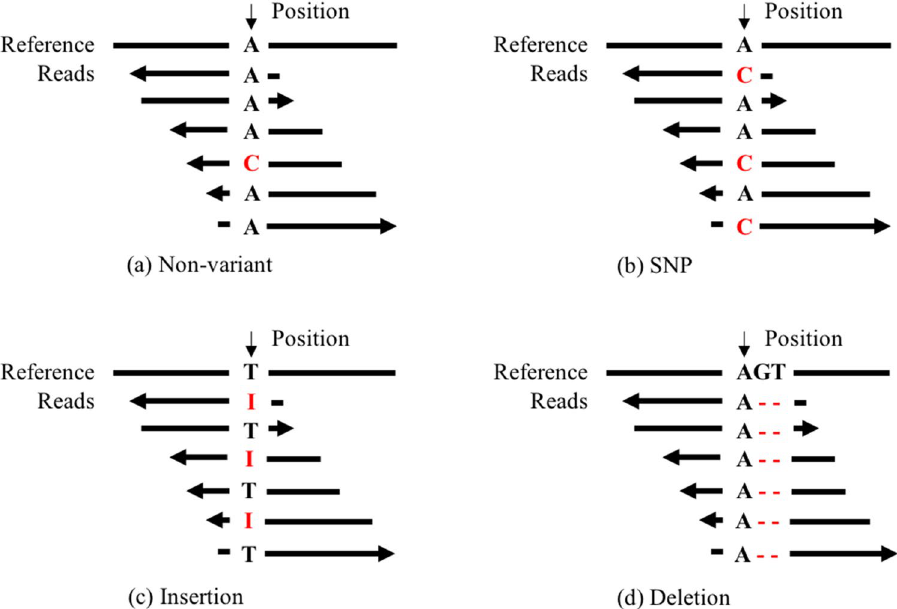
Figure 1. Examples of alignments for different genome variants. For easy understanding, we simplify illustration of the alignment. Each alignment consists of reference sequence and related reads. ( a ) is extracted at a non-variant genome site, where a difference C is from sequencing error. ( b ) indicates a heterozygous SNP variant with allele C. ( c ) is a heterozygous Insertion variant, for instance, from T to TAAT. ( d ) is a homozygous Deletion variant, i.e., from AGT to A. ( c ) and ( d ) are known as Indels variant.